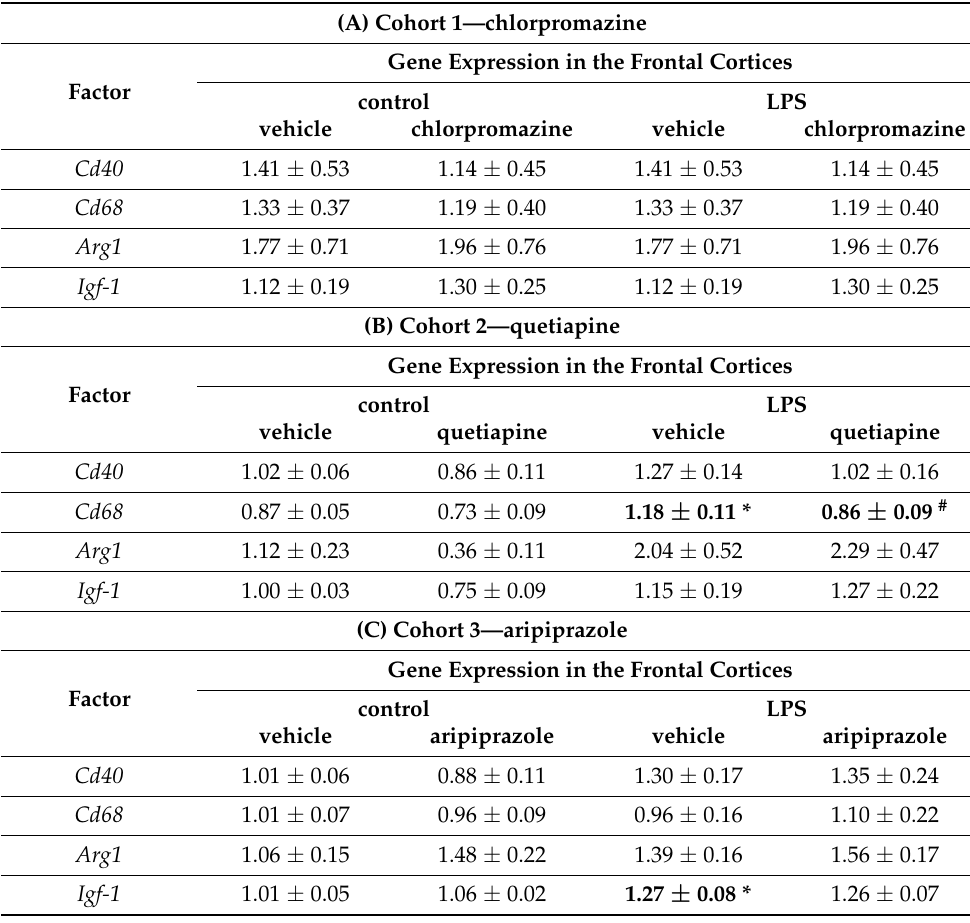
Table 3. The impact of prenatal exposure to LPS and subsequent chronic treatment with chlorpro- mazine ( A ), quetiapine ( B ) or aripiprazole ( C ) on Cd40 , Cd68 , Arg1 and Igf-1 gene expression in the frontal cortices of the offspring. The mRNA levels were measured using qRT-PCR with n = 4–6 (chlorpromazine), n = 6–9 (quetiapine) and n = 5–6 (aripiprazole) in each group. The results are presented as the average fold change ± SEM. * p < 0.05 vs. control + vehicle group, # p < 0.05 vs. LPS + vehicle